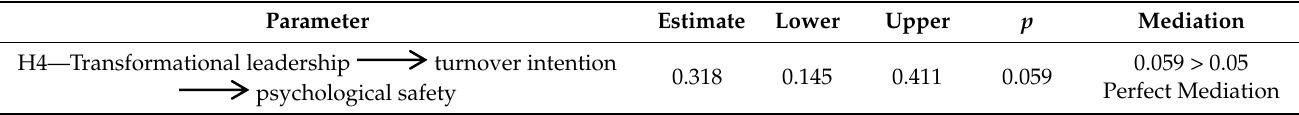
Table 4. The results of mediation effect.